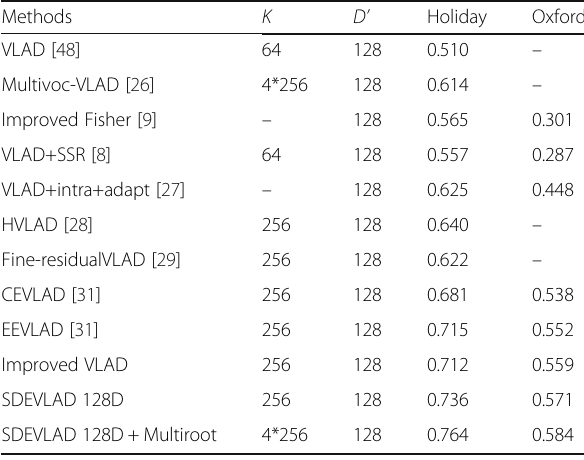
Table 3 SIFT descriptor results of image retrieval task on Holidays and Oxford for compact-size representation